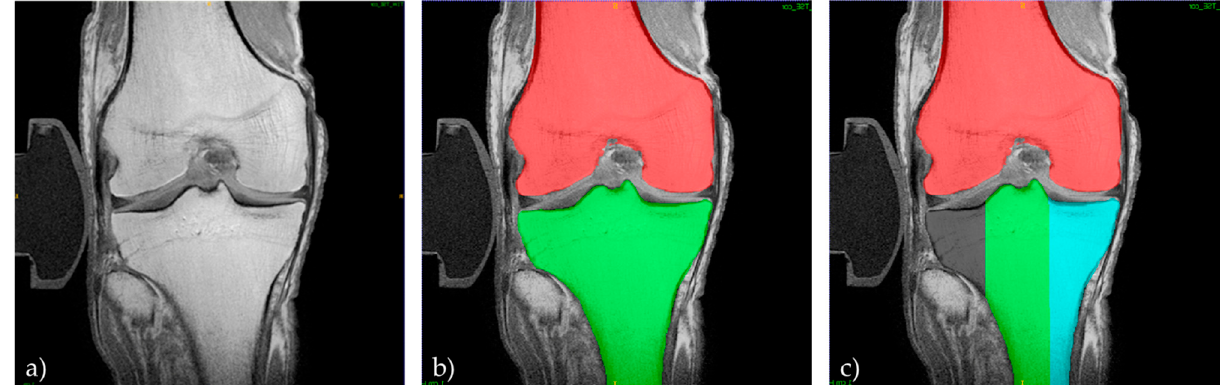
Figure 5. Manual segmentation procedure. For each joint, configuration, and condition, the coronal images of the T1-weighted sequence ( a ) were manually segmented and labelled as femur (red) and tibia (green) ( b ). The tibia was further compartmentalized into the medial (turquoise) and lateral (grey) tibial condyles and the intercondylar eminence was spared ( c ).